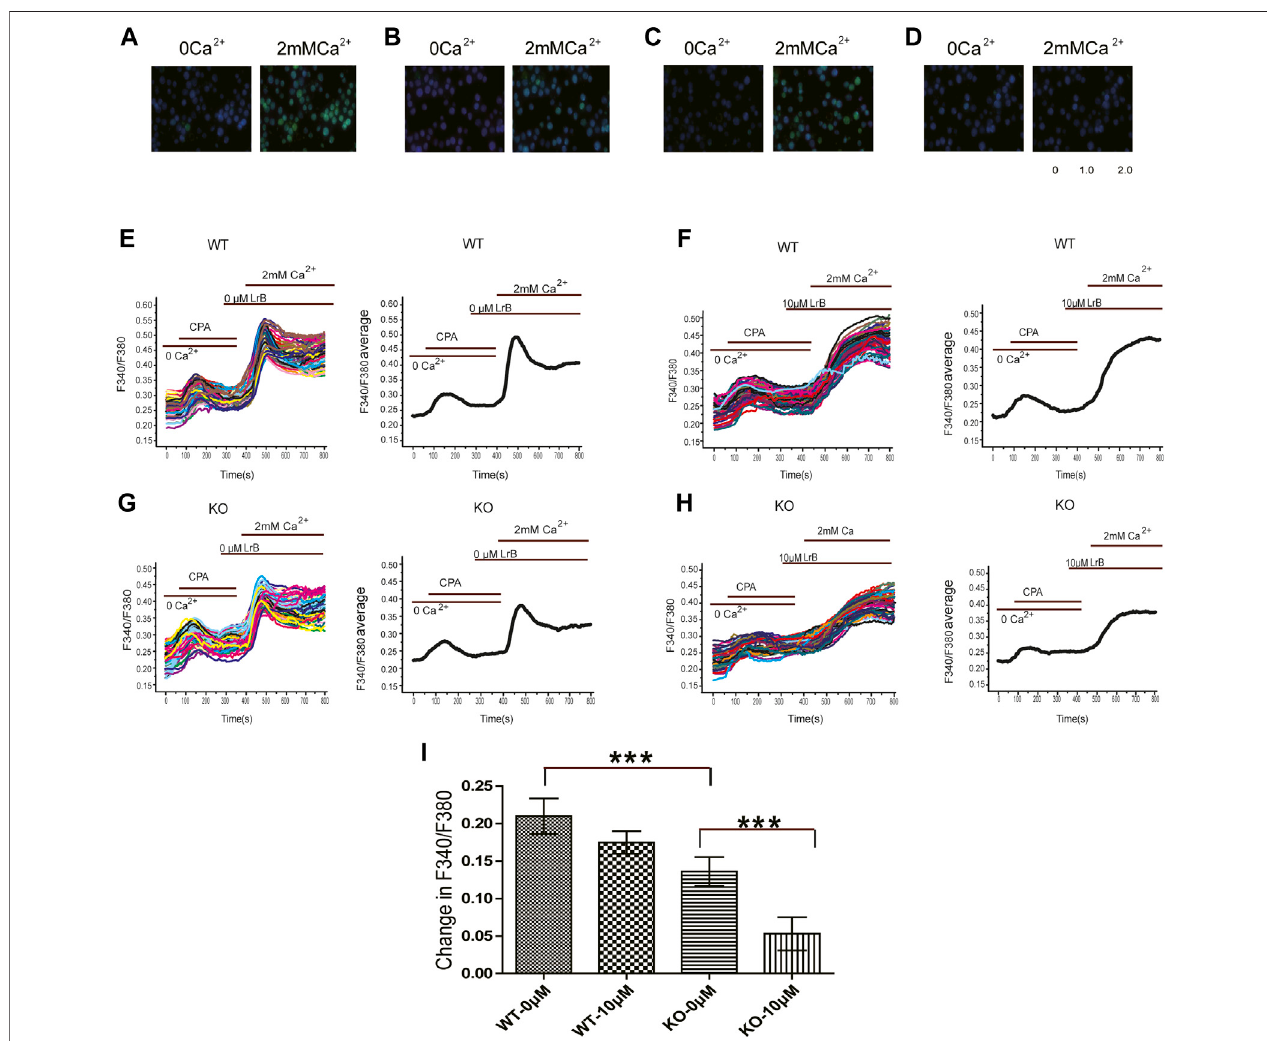
FIGURE 3 | Effects of LrB on [Ca 2+ ] i in Jurkat T cells. (A) [Ca 2+ ] i responses of wild type Jurkat T cells before (left) and after (right) 2 mM Ca 2+ perfusion; (B) [Ca 2+ ] i responses of wild type Jurkat T cells pretreated with 10 μ M LrB before (left) and after (right) 2 mM Ca 2+ perfusion; (C) [Ca 2+ ] i responses of the Kv1.3 KO Jurkat T cells before (left) and after (right) 2 mM Ca 2+ perfusion; (D) [Ca 2+ ] i responses of the Kv1.3 KO Jurkat T cells pretreated with 10 μ M LrB before (left) and after (right) 2 mM Ca 2+ perfusion; (E,F) RepresentativetracesofF340/F380 ratioshow [Ca 2+ ] i inwild type Jurkat Tcells treated withand withoutLrB; the fi rst small peak wascaused by10 μ MCPAdepletionofERCa 2+ store,thesecondpeakwascausedby2 mMCa 2+ perfusion; (G,H) .RepresentativetracesofF340/F380ratiointheKv1.3KOJurkat TcellstreatedwithandwithoutLrB; (I) StatisticanalysisofchangesinF340/F380inthewildtypeandKv1.3KOcellsafter2 mMCa 2+ perfusion betweencontrolandLrB treatment groups ( n (cid:2) 3, 100 – 250 cells were selected each batch). Datawere presented as mean ± SEM. Statistical analysis of differencesbetween groups was carried out using one-way ANOVA combined with Turkey ’ s post-hoc test. ***, p < 0.001.